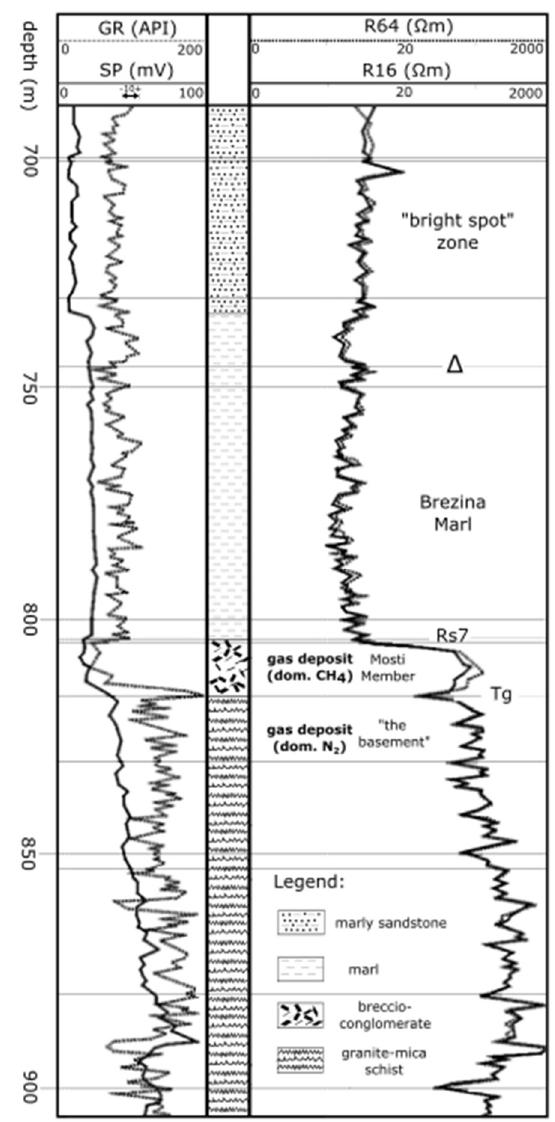
Figure 12. Conventional log in the Paleozoic basement rocks, well Gr–1z, eastern Bjelovar Subdepression (original redrawn from [1,41]).